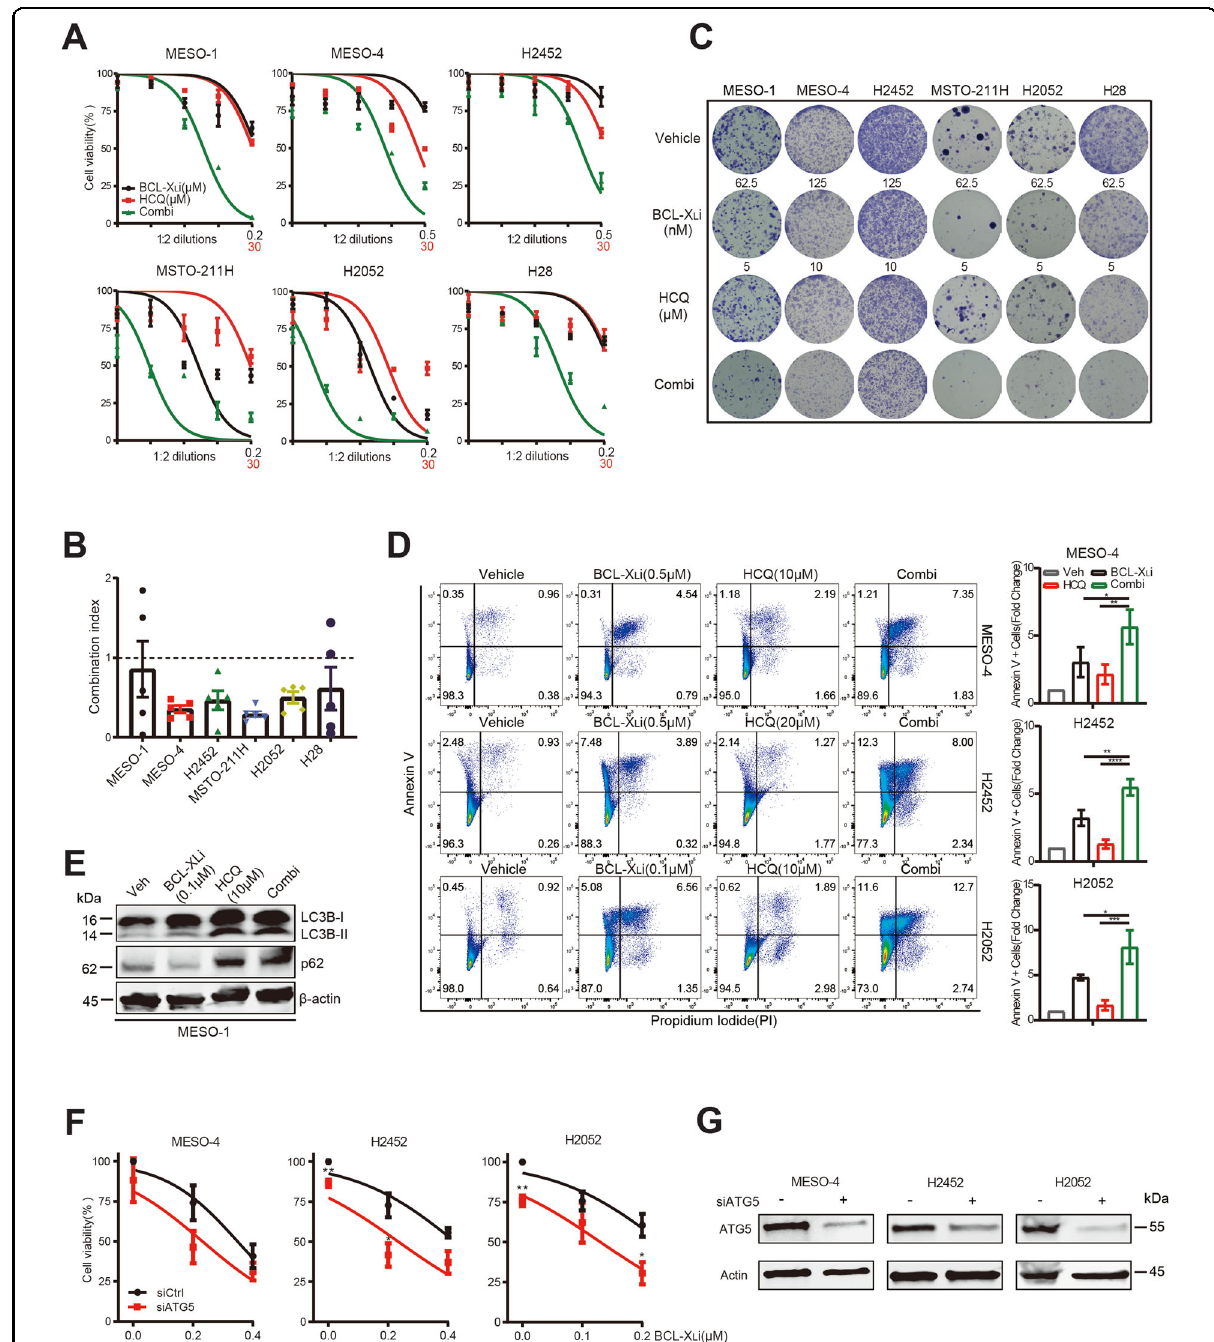
Fig. 5 Dual inhibition of BCL-X L and autophagy synergistically enhances antiproliferative effects and increases apoptosis. A , B Dose- response curves ( A ) of MPM cells treated with A-1155463 and HCQ, alone or in combination, for 96 h. Combination index (CI) values ( B ) were determined by the CompuSyn software. Data were shown as mean ± s.d. ( n = 3). CI < 1.0, synergism; CI = 1.0, additive effects, CI > 1.0, antagonism. C Clonogenic assay of MPM cells treated for 96 h with A-1155463 and HCQ, alone or in combination. Cells were cultured without the drug for additional 12 days before crystal violet staining. Representative images of three independent experiments ( n = 3) are shown. D Flow cytometry- based apoptosis assay of MPM cells treated with A-1155463 and HCQ, alone or in combinations for 48 h. Data were presented as mean ± s.d. ( n = 3), with a representative plot shown in the left. * p < 0.05, ** p < 0.01, *** p < 0.005, and **** p < 0.001 by one-way ANOVA with Sidak ’ s multiple comparisons test. E Immunoblots of MESO-1 cells treated with A-1155463 and HCQ, alone and in combination, for 24 h. F , G MPM cells transfected with ATG5 - or control siRNAs (siATG5, siCtrl) were analyzed (48 h post-transfection) by immunoblots ( F ) or treated with A-1155463 for another 24 h, followed by quanti fi cation of viable cells ( G ). Data were shown as mean ± s.d. ( n = 3). * p < 0.05 and ** p < 0.01 by unpaired t